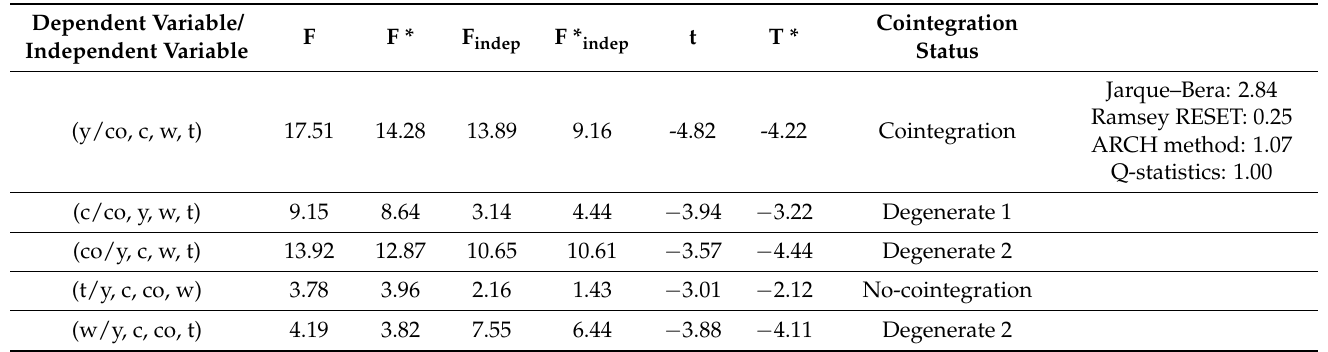
Table 7. The results of the panel ARDL bounds testing cointegration